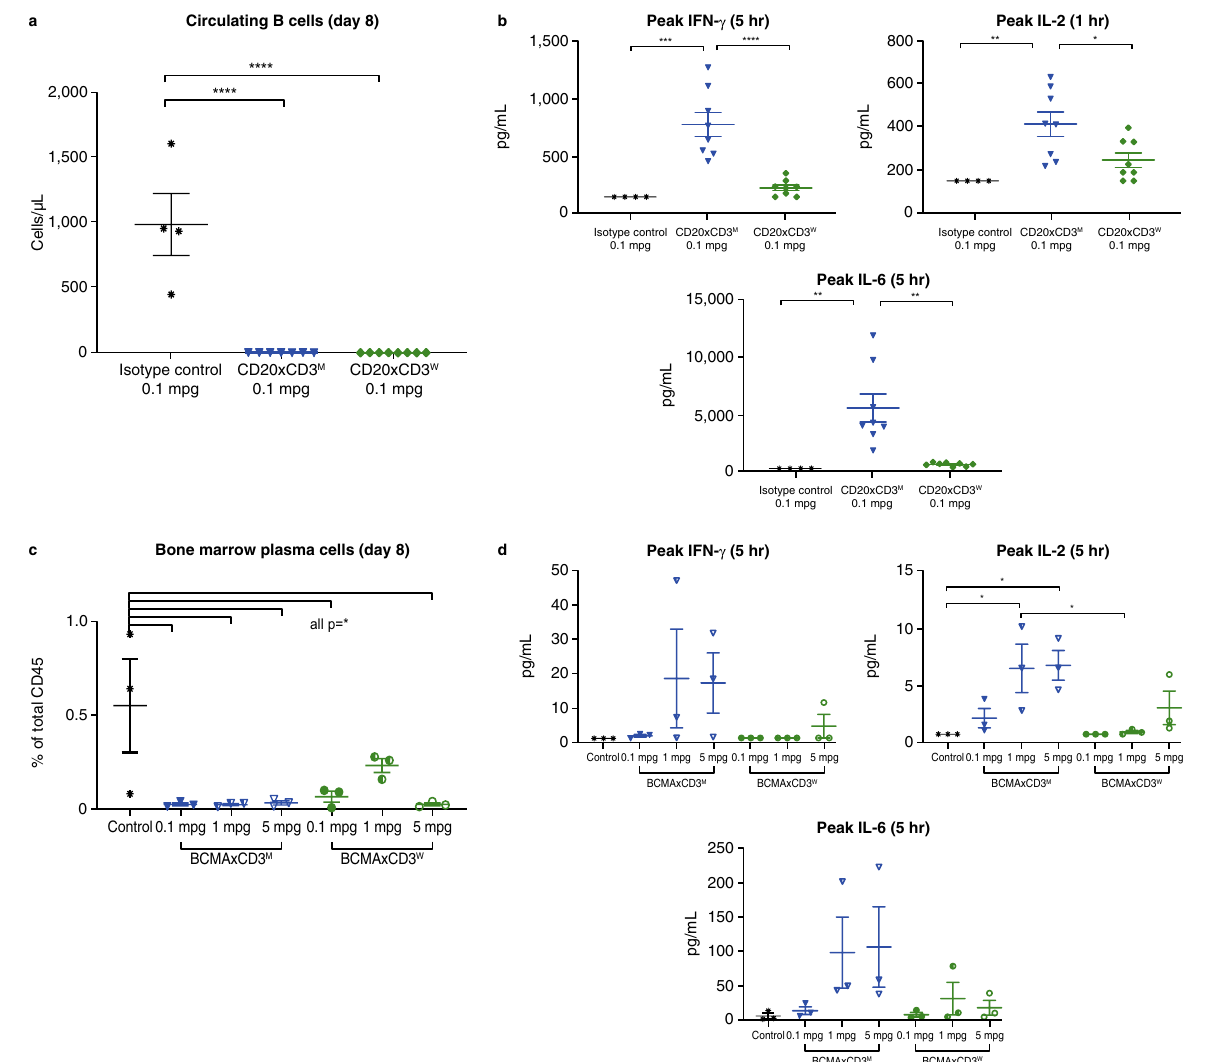
Figure 9. Potency of CD20xCD3 and BCMAxCD3 bispecific antibodies in cynomolgus monkeys. The number of circulating B cells after CD20xCD3 bispecific antibody treatment was determined by flow cytometry and reported as cells/µL blood ( a ), and peak cytokines were measured in serum by MSD and reported as pg/mL ( b ) . The number of bone marrow plasma cells after BCMAxCD3 bispecific antibody treatment was determined by flow cytometry and reported as percent of total CD45 + cells ( c ), and peak cytokines were measured in serum by MSD and reported as pg/mL ( d ). Statistical analysis by ordinary one-way ANOVA with Tukey’s multiple comparisons test. * P < 0.03, ** P < 0.007, *** P < 0.0004, and **** P < 0.0001. ANOVA analysis of variance; BCMA B-cell maturation antigen; MSD Meso Scale